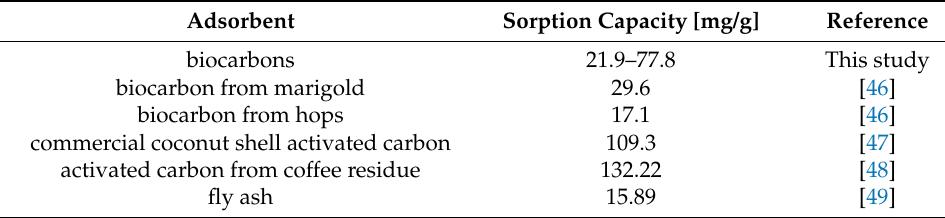
Table 9. Comparison of sorption capacities (H 2 S) of biocarbons with other adsorbents reported in